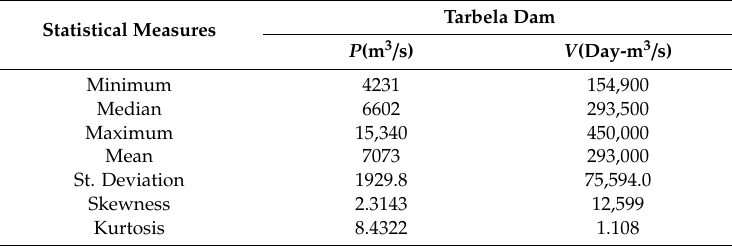
Table 2. Statistical characteristics of the peak flow and